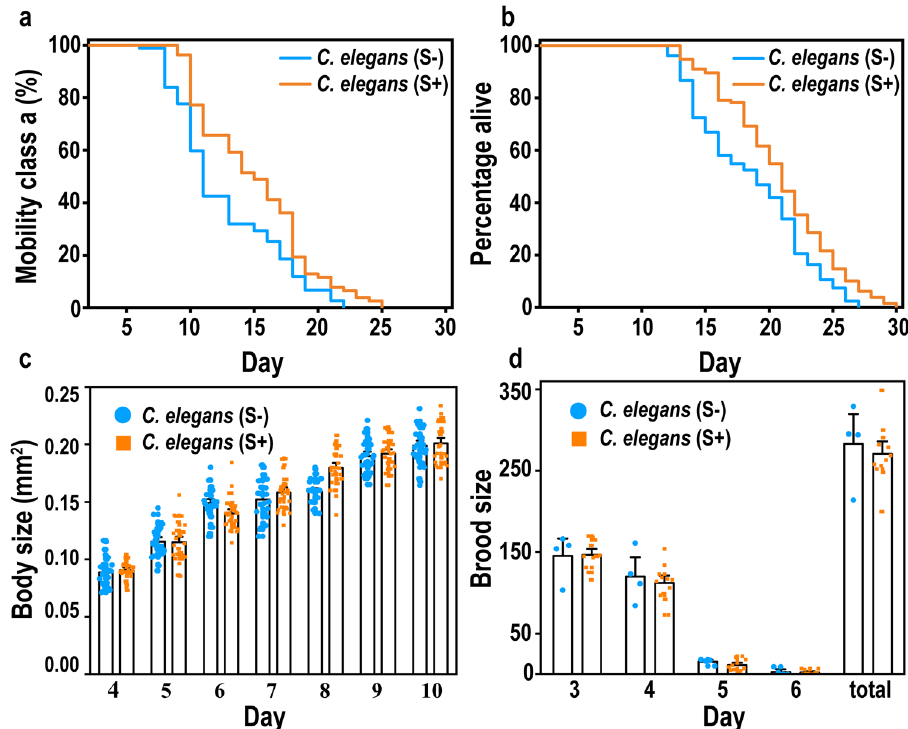
Fig. 2 Phenotypic changes observed for Caenorhabditis elegans fed PT-containing food after the L4-to-adult molt. a The percentage of nematodes with class a motility ((S + )-fed C. elegans were more active; p -value < 0.01, n S + = 78, n S- = 75). b Percentage alive in the two groups of worms, observed from the nominal age of 3 days ((S + )-fed C. elegans had longer lifespans; p -value < 0.01, n S + = 132, n S- = 124). c Body sizes of the two groups of nematodes (no signi fi cant change; n S + > 14, n S- > 20). d Brood sizes of the two groups of nematodes (no signi fi cant change; n S + = 8, n S- = 8). p -values were calculated with log-rank